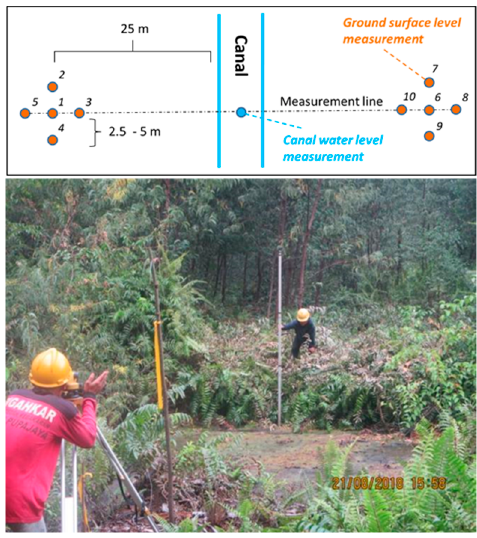
Figure 4. Schematic and photo of CWD validation measurements across a canal in the field.